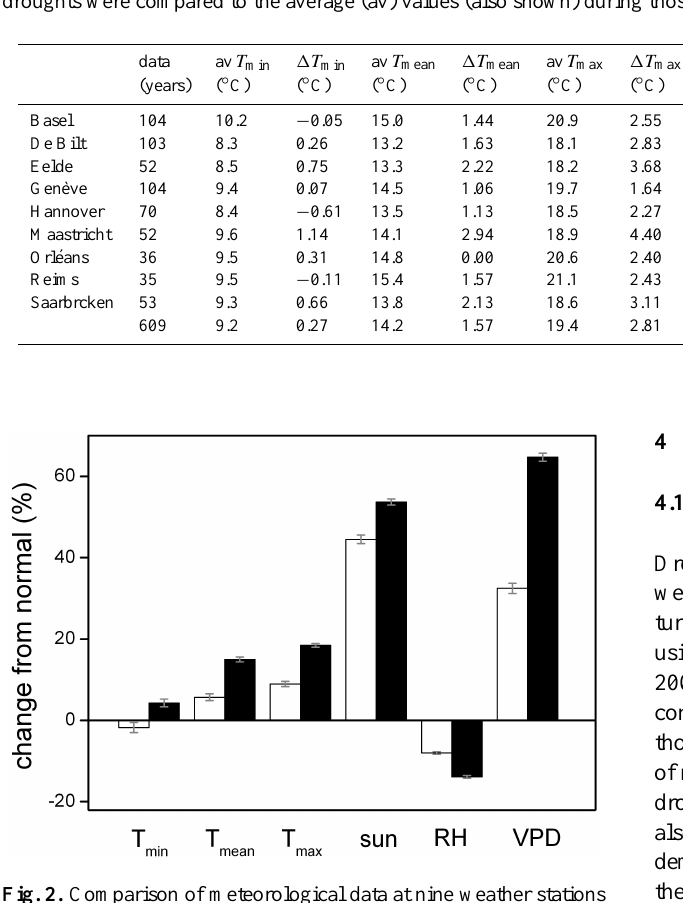
Fig. 2. Comparison of meteorological data at nine weather stations throughout Western Europe (details: see Table 1) the first 10 days of a drought (definition: see text), white bars, with the period 11th day of a drought until the drought end, black bars. The average relative change to normal conditions (all data excluding droughts) is depicted ± standard